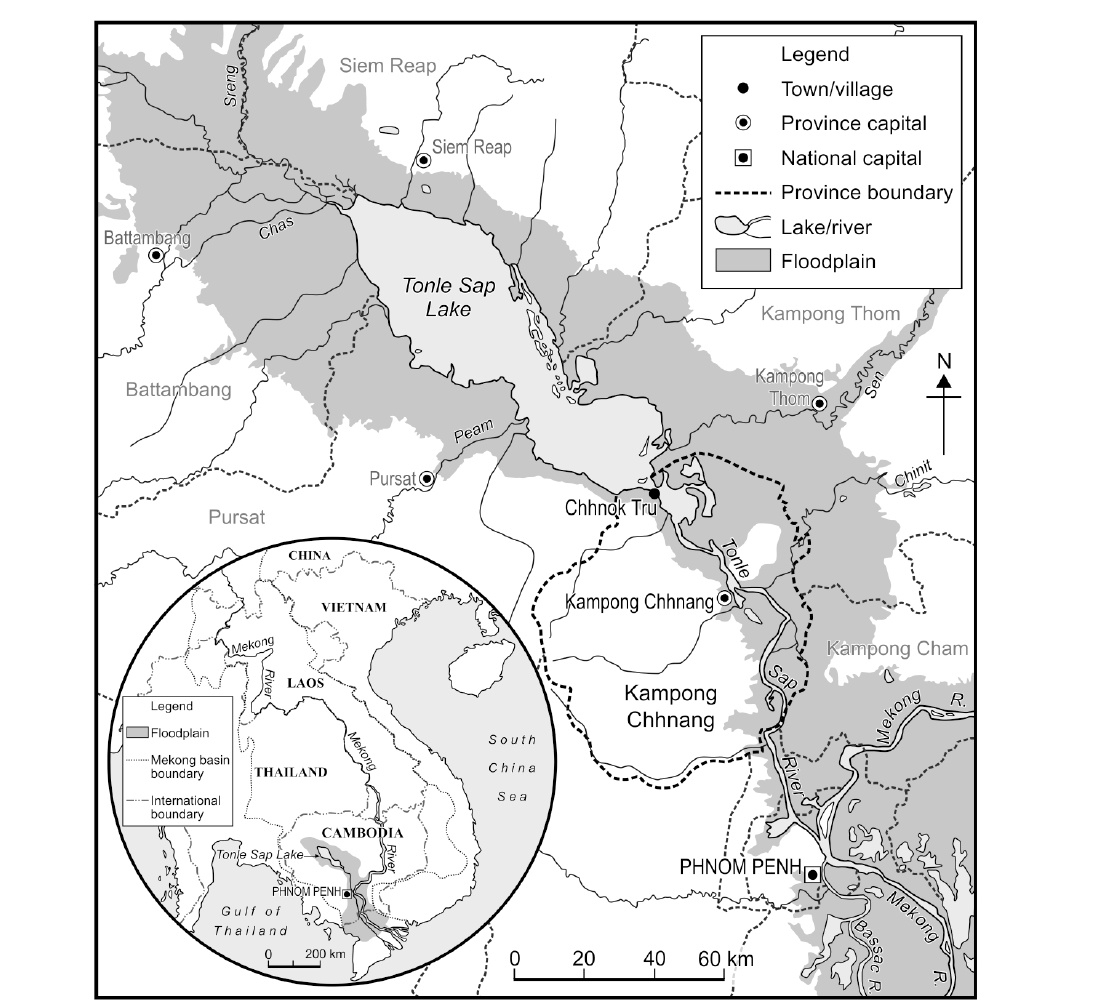
Fig. 2 . Tonle Sap Lake and location of Chhnok Tru village,